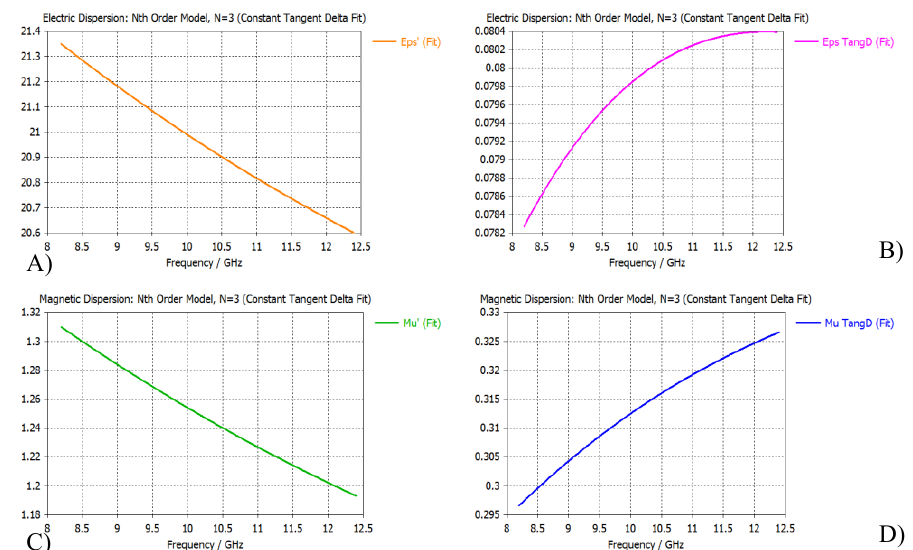
Fig. 6. Electromagnetic parameters of ПКМ - 35Ж ceramics: А)permittivity; B) dielectric loss tangent; C)permeability; D)magnetic loss